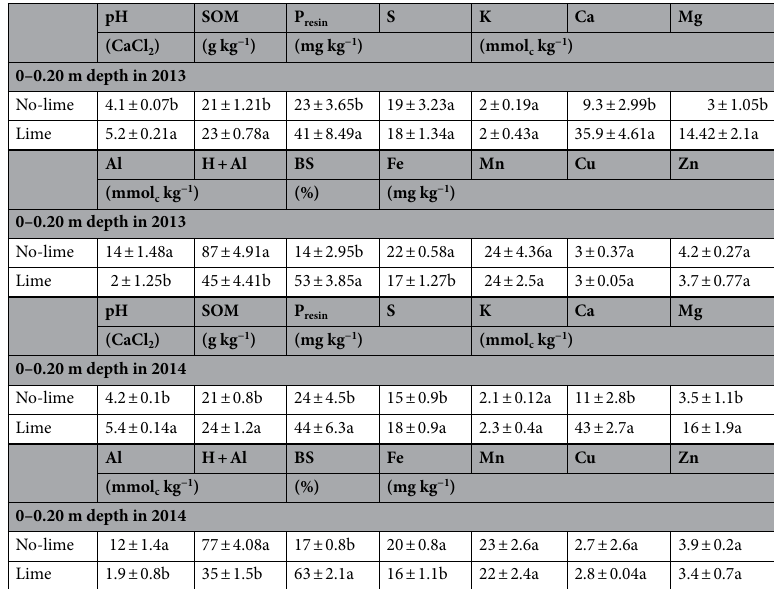
Table 1. Chemical characteristics of the soil at 0–0.20 m depth in 2013 and 2014. Means ± standard error followed by different letter differ by the t-test at 0.05 confidence